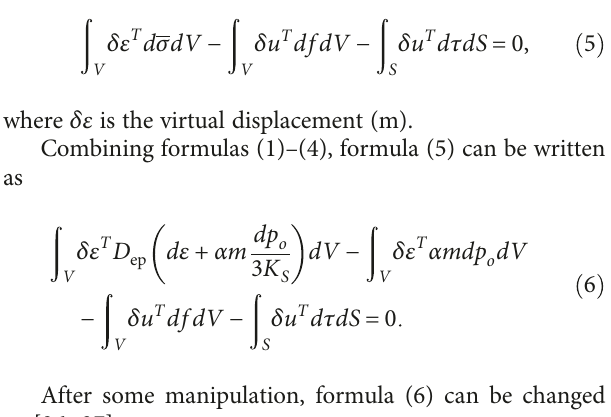
Figure 1: Fluid fl ow in a cohesive element.